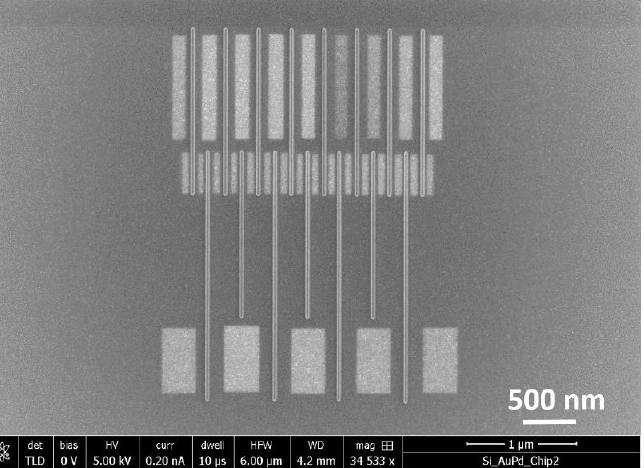
Figure 8. SE image of array identical to that in Figure 7 after etching in between the lines with higher resolution, making sure to leave the FEBID lines unaffected.